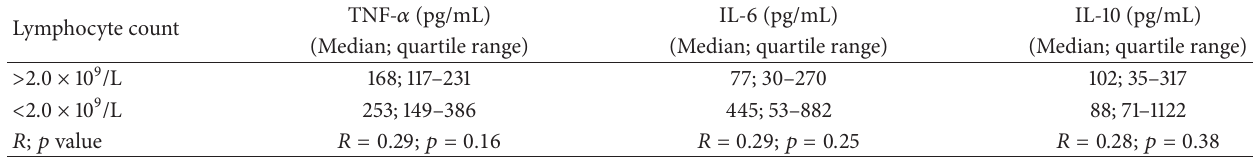
Table 5: Relationship between cytokine levels and lymphocyte